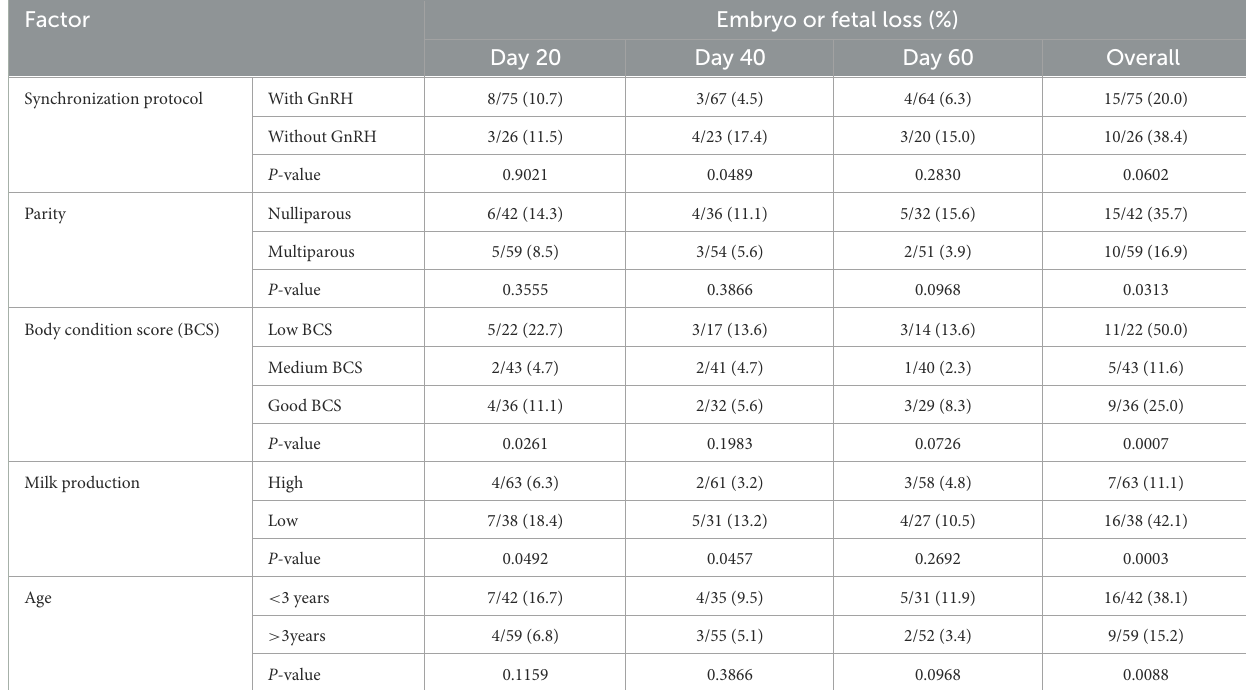
TABLE 2 Variation of pregnancy losses in buffaloes in response to synchronization protocol, parity, body condition score, age, and milk production. Factor Embryo or fetal loss (%)